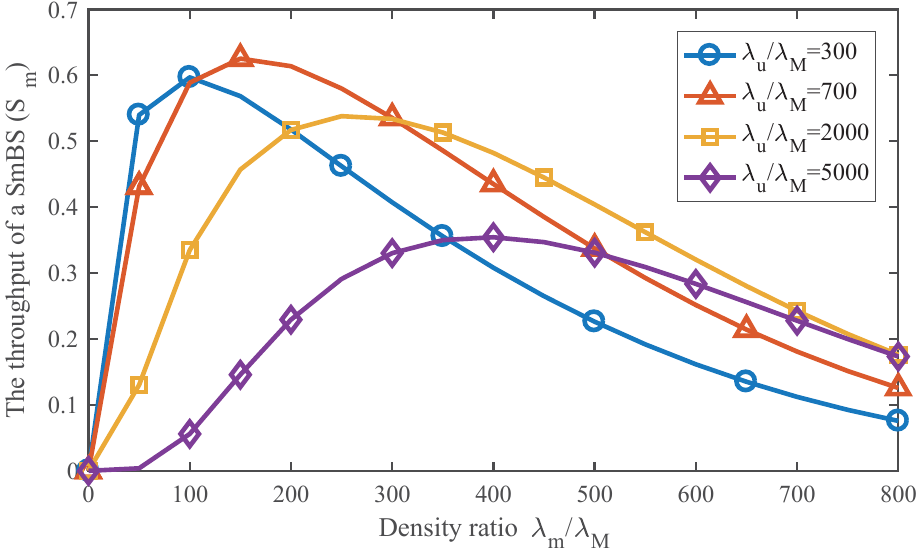
Figure 9. The impact of SmBS density on the throughput of an SmBS. P m / P M =